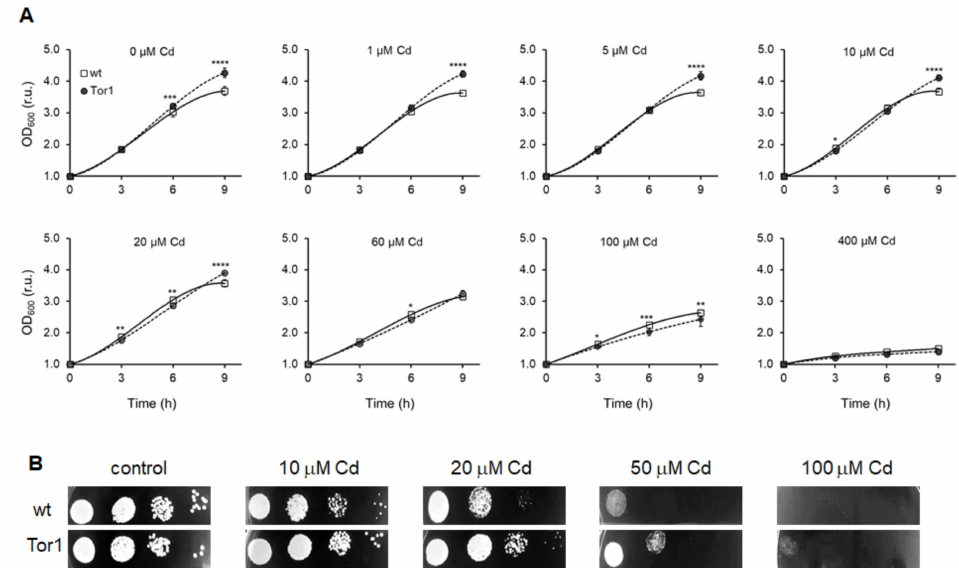
Figure 2. Growth of wild-type and Tor1-null cells exposed to Cd. ( A ) Growth curves of both tested yeast strains 3, 6, and 9 h after treatment with increasing Cd concentrations demonstrate the dose-dependent negative e ff ect of increasing the Cd concentration on the cell growth (relative units, r.u. represent relative increase in OD 600 compared to time point 0